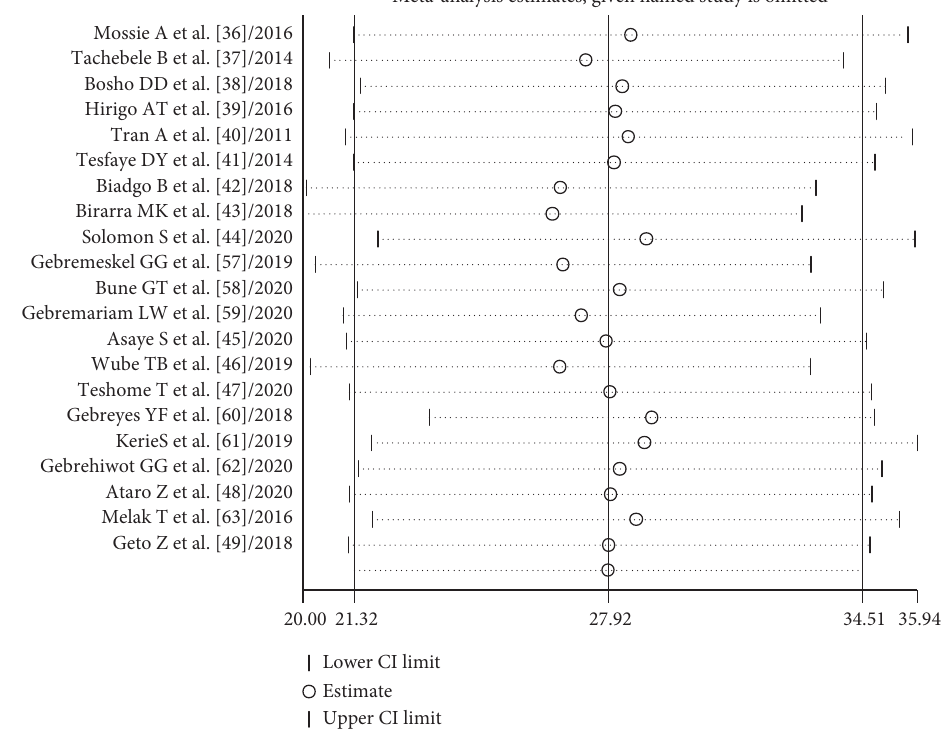
Figure 7: Sensitivity analysis based on IDF criteria.